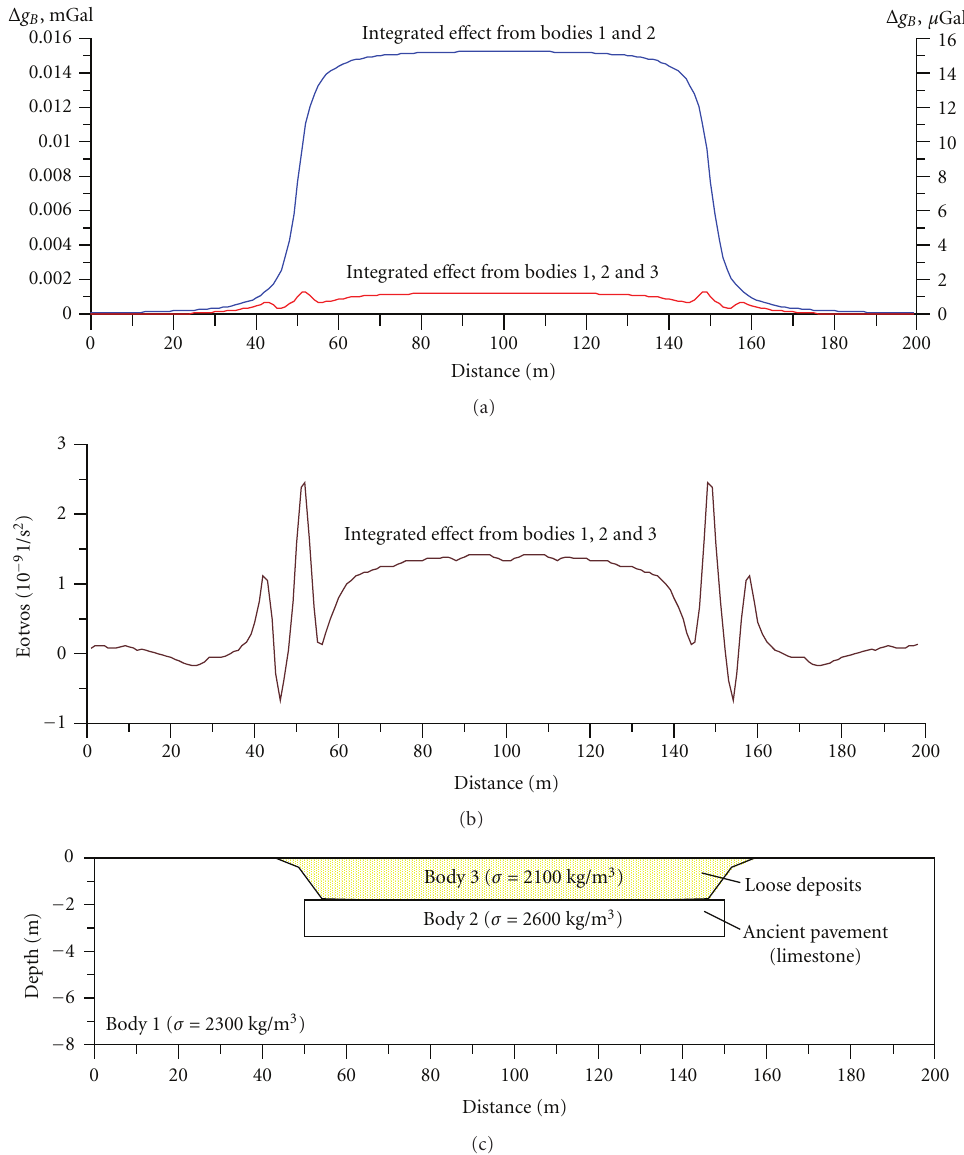
Figure 4: Comparison of Bouguer gravity and vertical gradient anomalies. (a) Bouguer gravity, (b) vertical gradient g z ( W zz ) computed for the base of 1.2m, and (c) archaeological